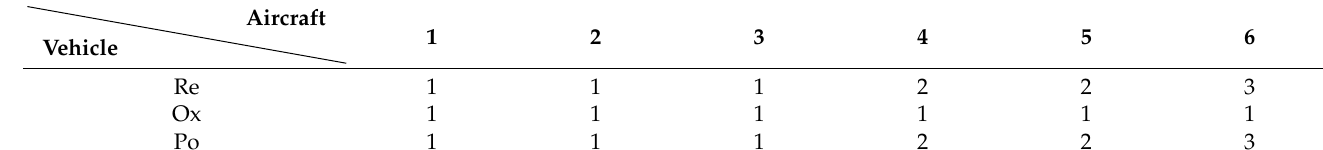
Table 4. Number of support vehicles for a certain type of aircraft.